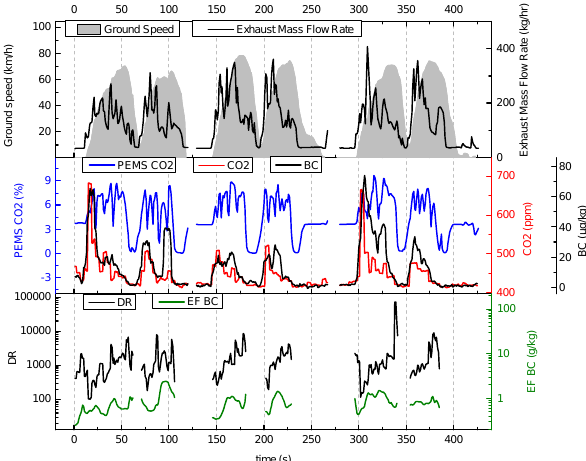
Figure 4. Tailpipe measurements performed with portable emission measurement system (PEMS) are ground speed (shaded grey) and exhaust mass flow rate (black) – top; and CO 2 (blue) – middle. Also in the middle plot are CO 2 and BC measured with mobile station in red and blue, respectively. Calculated dilution ratio (DR) in black and BC EF in green – bottom. BC EF does not show any significant dependence on DR. Note the log scales for DR and